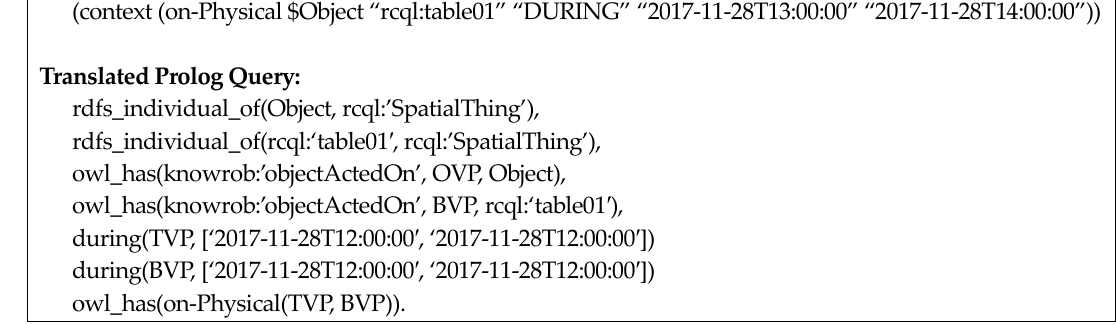
Figure 15. Illustration of translation for spatio-temporal query pattern two.